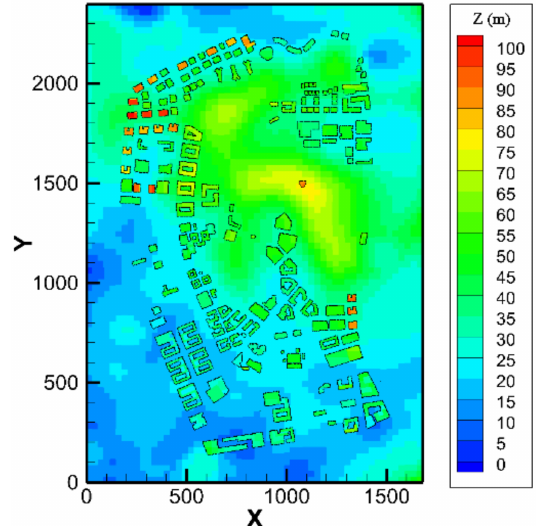
Figure 3. CFD model diagram of computational